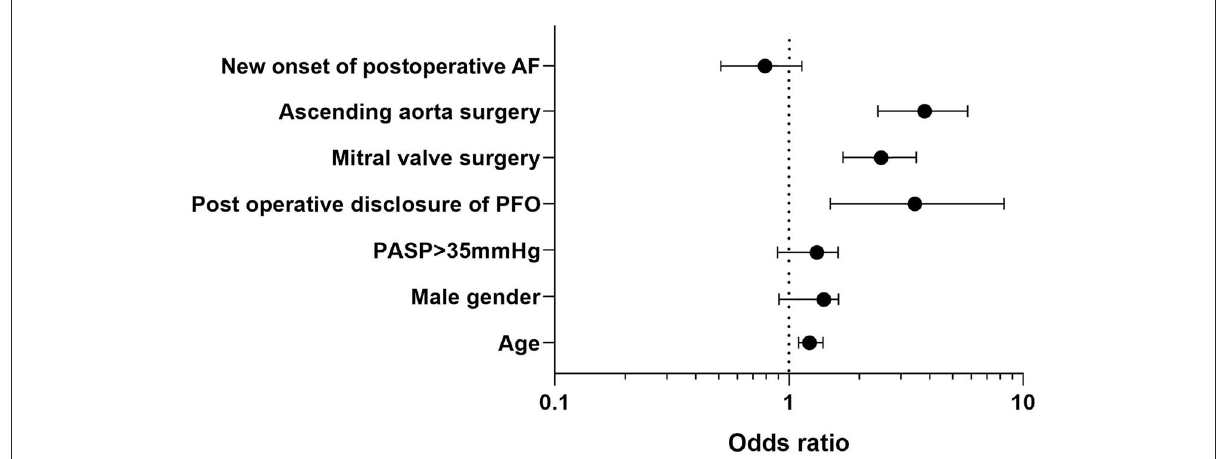
FIGURE2 Variables associated with ischemic strokes in multivariable logistic regression